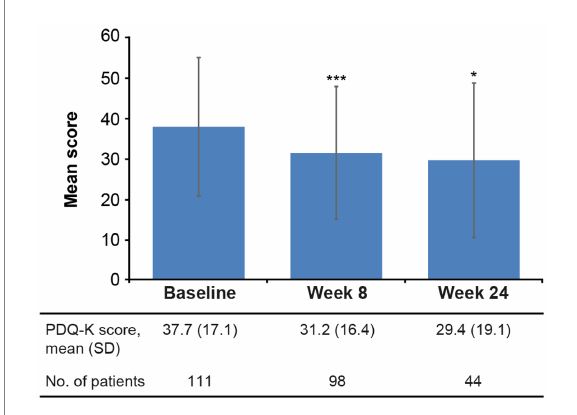
FIGURE 3 Mean (SD) PDQ-K total score at baseline and after 8 and 24 weeks of vortioxetine treatment (effectiveness analysis set). * p < 0.05 and *** p < 0.0001 vs. baseline. PDQ-K, Perceived Deficits Questionnaire–Depression, Korean version; SD, standard deviation.